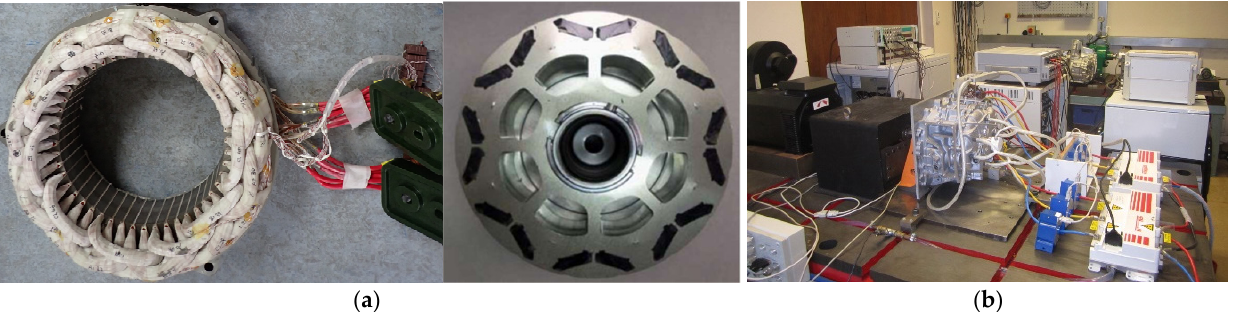
Figure 40. Photos of prototype and test rig: ( a ) prototype; ( b ) test rig.